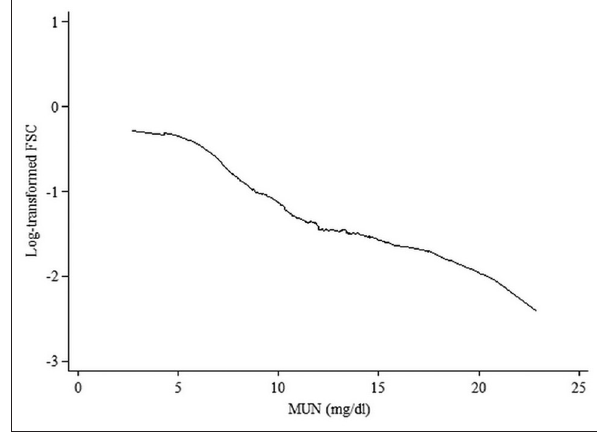
Figure-1: Lowess smoothing curve is testing the linearity of the relationship between milk urea nitrogen concentration and first service conception among 295 cows on 43 smallholder dairy farms in Thailand in